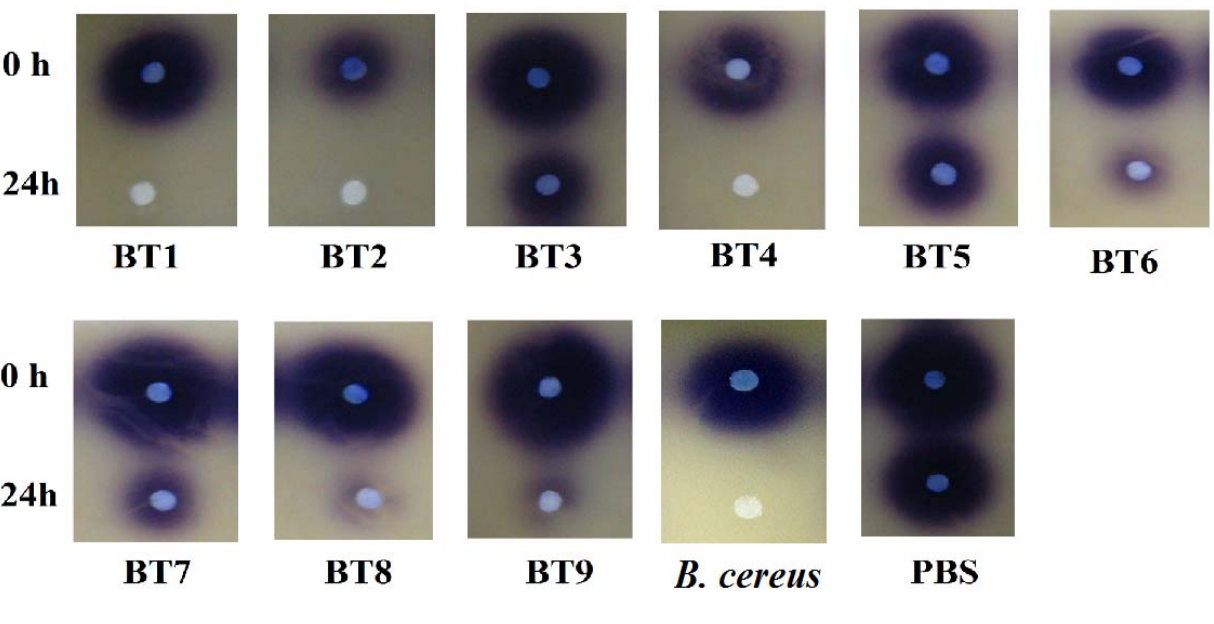
Figure 1. Detection of QQ activities using CV026 overlay. C6-HSL was incubated with bacterial cell suspensions for 0 h and 24 h. Positive result in QQ activity was depicted by the reduction or abolishment of purple pigments after 24 h of incubation. The positive and negative controls were B. cereus and PBS, respectively. See Table 2 for strains